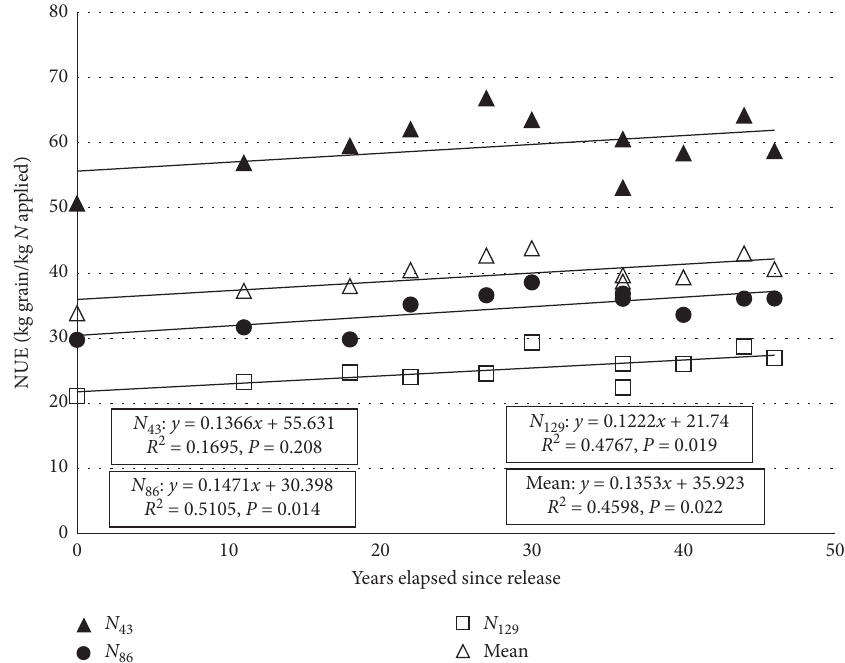
Figure 5: Relationship of NUE of 11 bread wheat cultivars released between 1960 and 2006 and grown at different N levels for two seasons (2006/07 and 2007/08) with the time elapsed since their year of release.